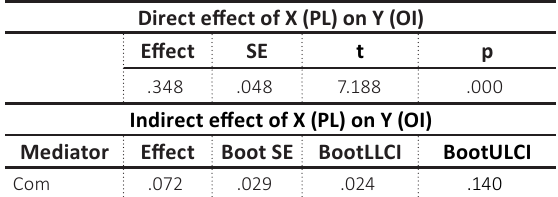
Table 5. Mediating effect of compassion in the relationship between positive leadership and organizational